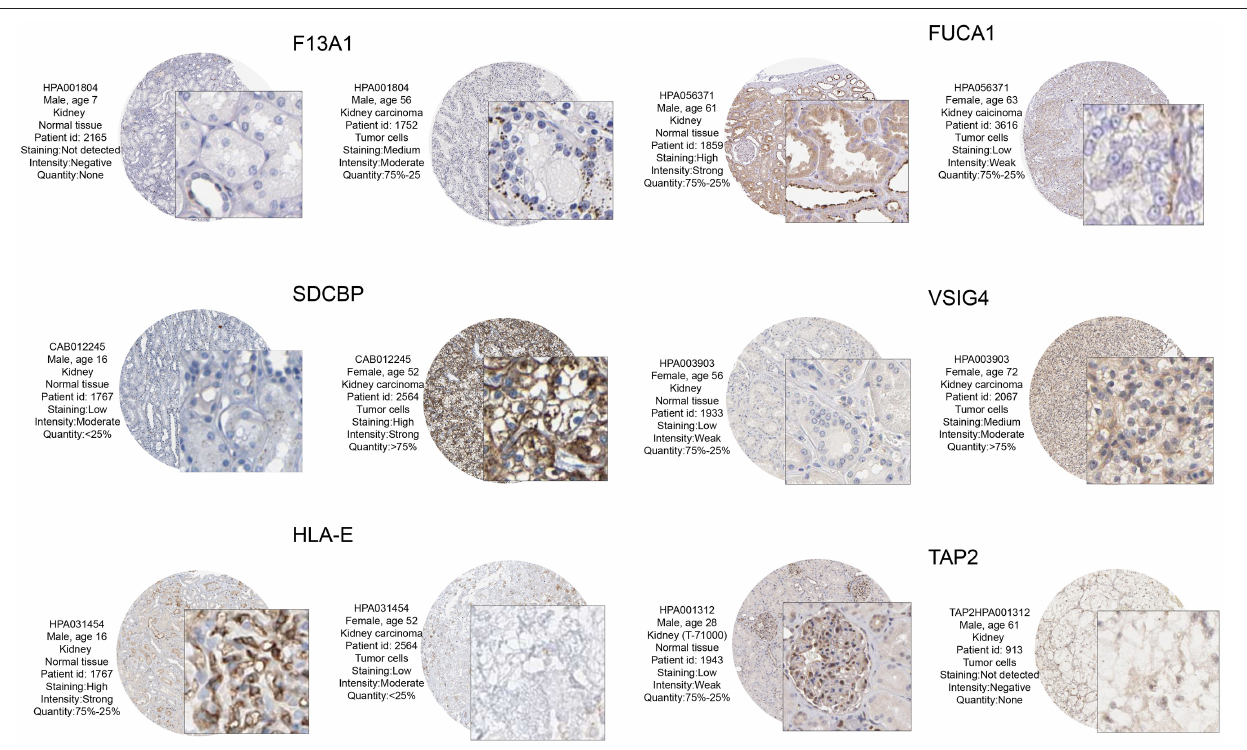
FIGURE 8 | From the HPA database to verify protein expression-level differences of these candidate genes. Of these, F13A1, SDCBP, and VSIG4, and corresponding immunohistochemical samples, the degree of renal clear cell carcinoma tissue staining is higher than in normal kidney tissue. In FUCA1, HLA – E, and TAP2, and corresponding immunohistochemical samples, the degree renal clear cell carcinoma tissue staining is lower than in normal kidney tissue. These M2 macrophage gene protein levels at the transcription level were similar to those of the prognostic